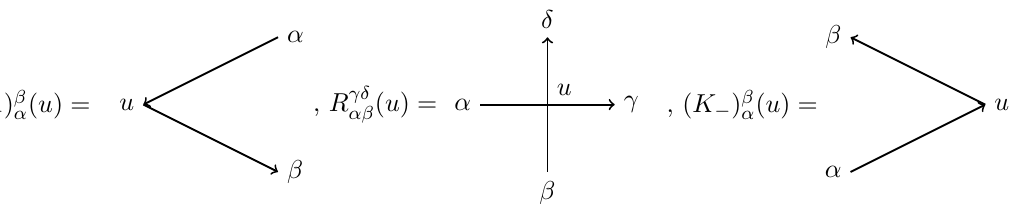
Figure 1 . R -matrix and K -matrices in graphical notation.